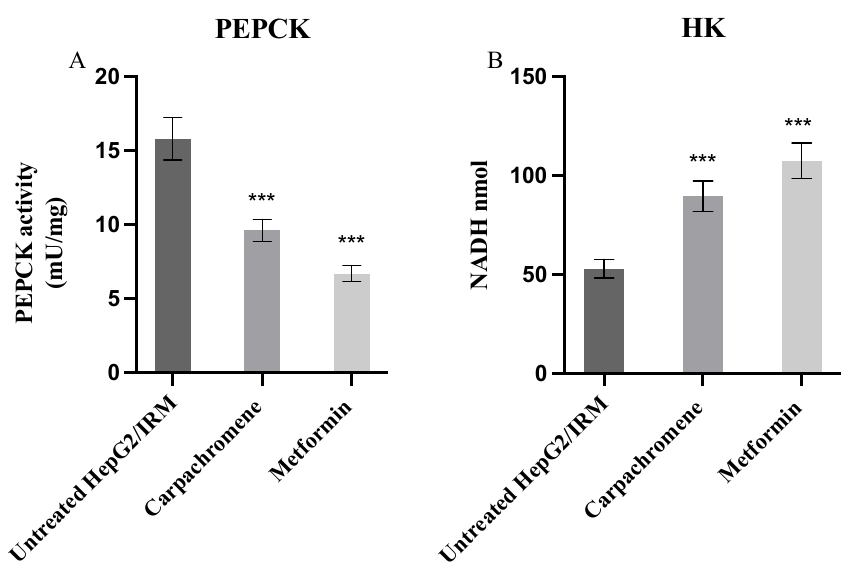
Figure 6. Effect of carpachromene (20 μ g/mL) on the activity of ( A ) PEPCK and ( B ) HK enzymes on HepG2/IRM cells. Metformin was used as positive control. Bars represent mean ± SD ( n = 3), significant difference was analyzed by one-way ANOVA followed by Dunnett test, *** p < 0.001, when compared to untreated HepG/IRM cells.